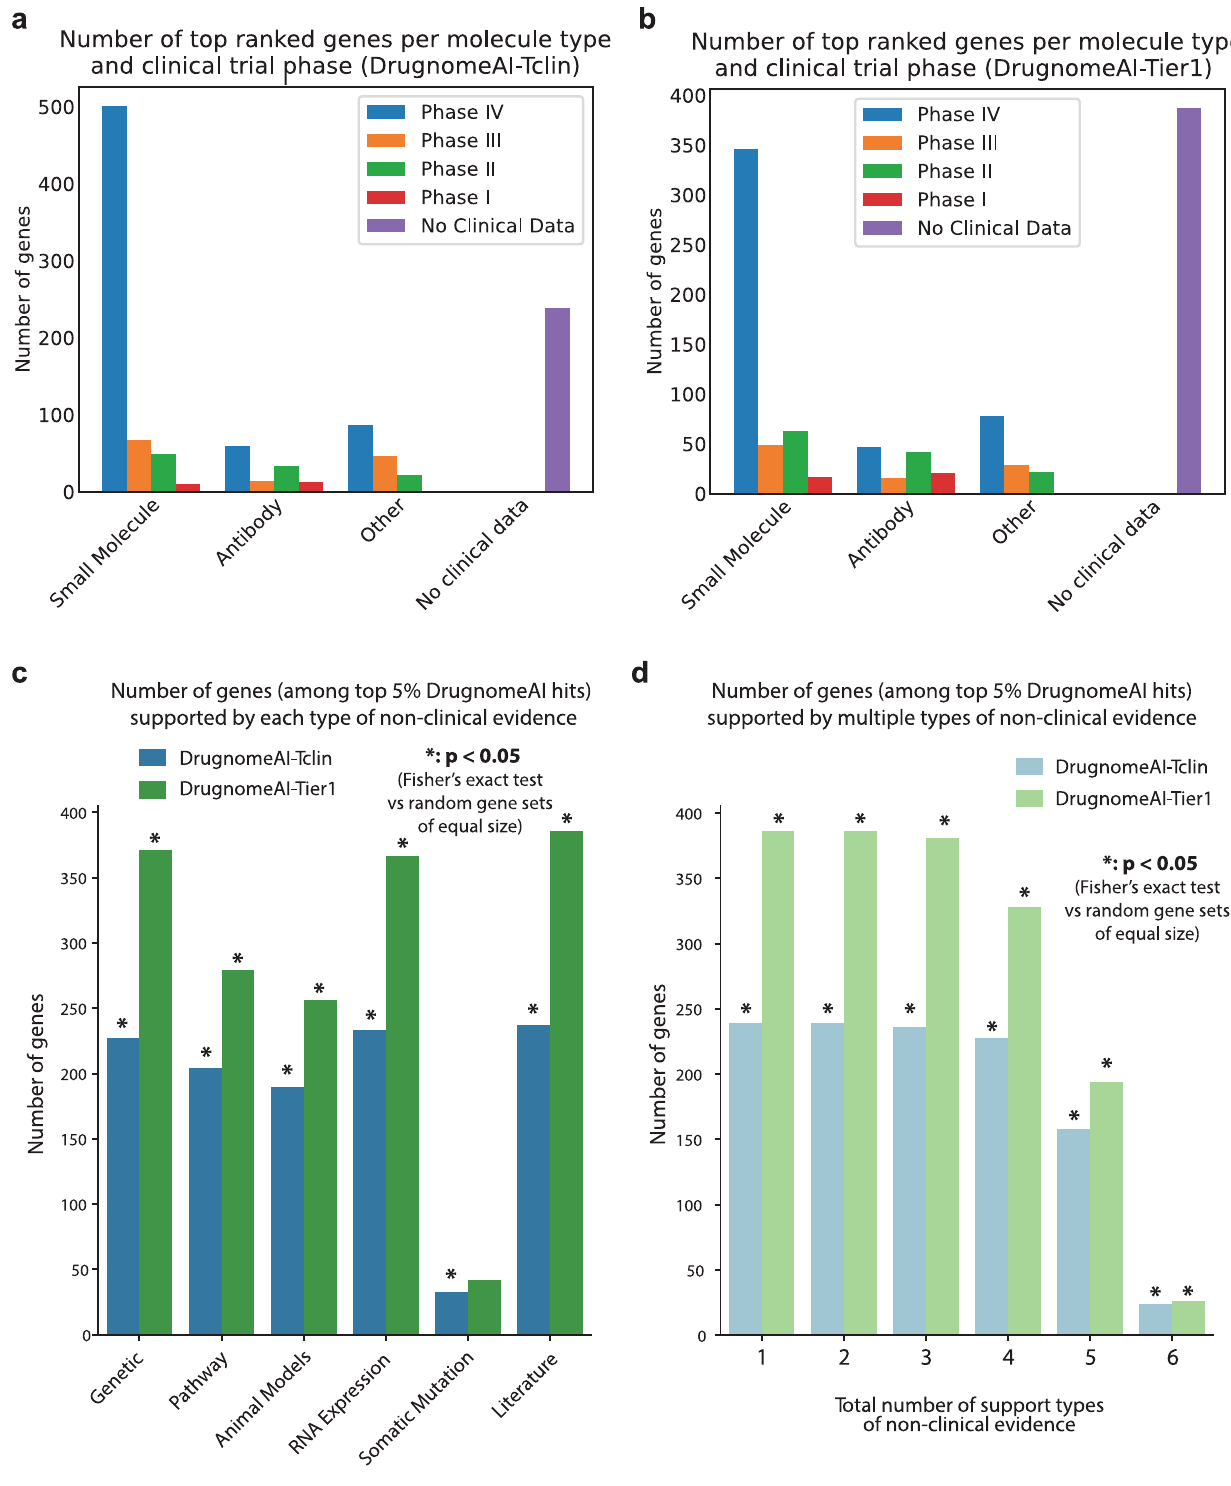
COMMUNICATIONS BIOLOGY| (2022) 5:1291